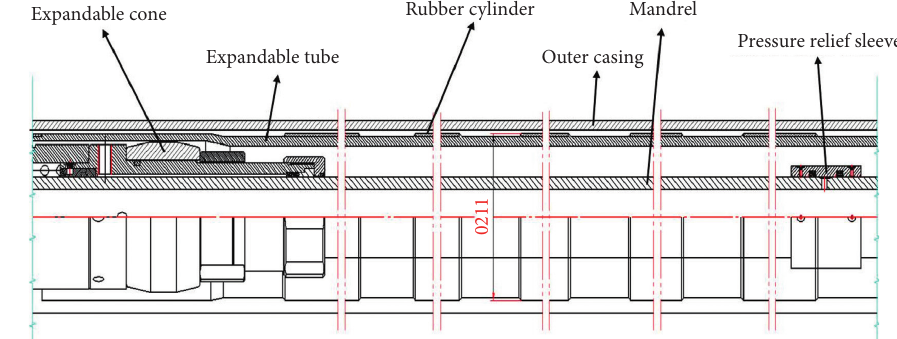
Figure 1: Structure of the expansion portion of the expansion liner hanger.